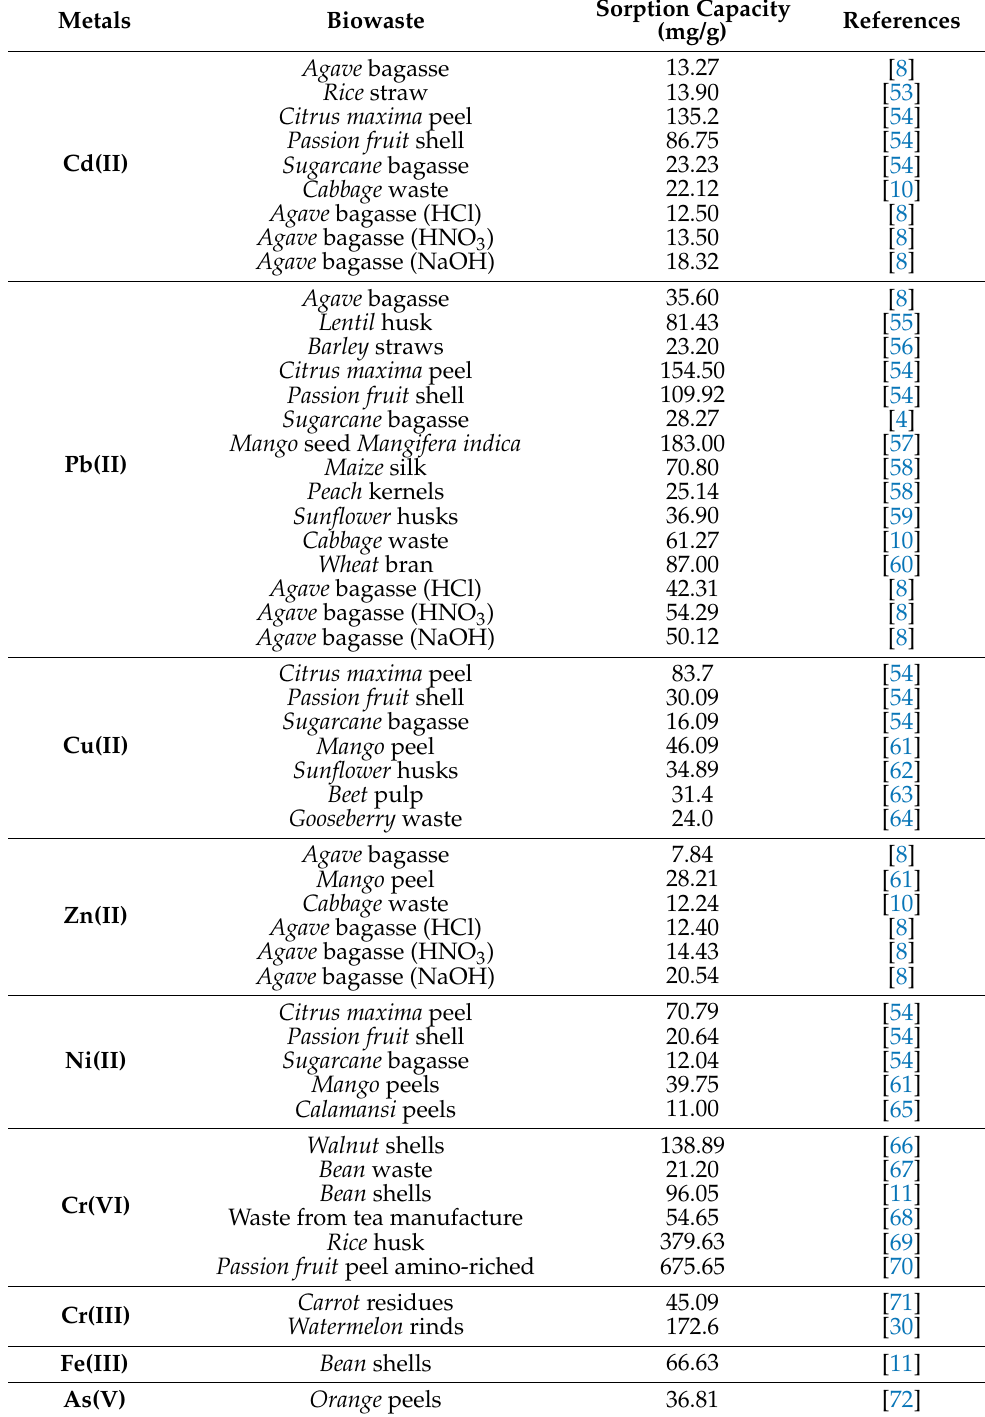
Table 1. Biowaste from agricultural production and the food industry used to remove heavy metals from